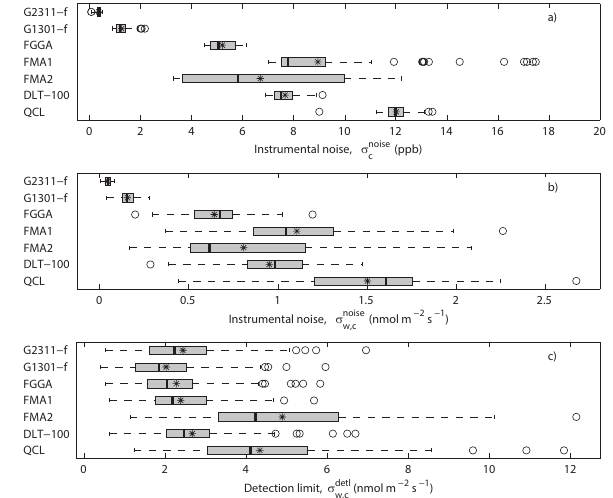
Figure 4. Boxplots of instrumental noise (upper two plots) and de- tection limit (bottom plot) calculated based on the methods pre- sented in Sect. 3.5. Only periods when all the instruments were working and the CH 4 flux was below 30nmolm − 2 s − 1 were used (129 points) for the detection limit plot. For the instrumental noise plots periods when all the instruments were working and the in- strumental noise was estimated successfully were used (99 points). Grey boxes show the interquartile range, vertical lines within the boxes show medians, stars show the means, dashed whiskers show the limits for outliers and circles show values outside these limits. LI-7700 is not shown due to the data-logging problem outside the